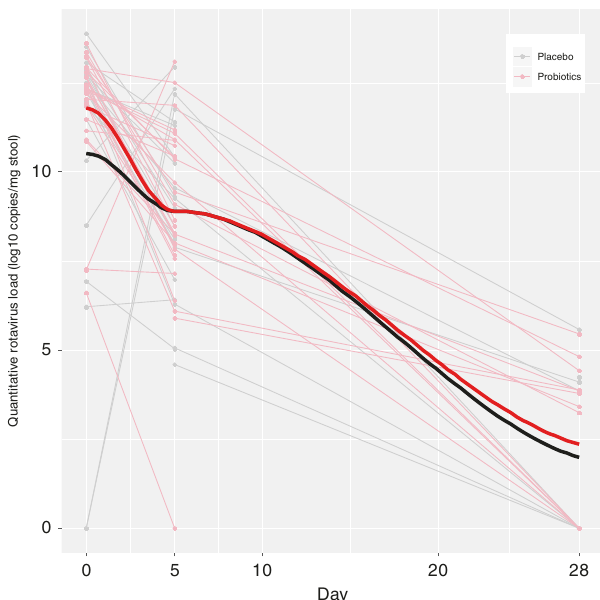
Fig. 5 Change in rotavirus viral load quantity in stool over time, compared between probiotic and placebo groups. Stool Log10 transformed copies of rotavirus by treatment group [probiotic ( N = 30) vs. placebo ( N = 24)] across time (in days) following randomization on the x - axis. Thin light gray lines refer to patients provided placebo, this red lines refer to those provided probiotic; thick black and red lines to locally weighted smoothing lines respectively. The two-sided P -value represents the result of a linear mixed effect model with random intercepts (subjects random effect) comparing placebo (reference group) vs. probiotic on viral load, including time and treatment group variables, and an interaction term for the latter two. Source data are provided as a Source Data fi le.